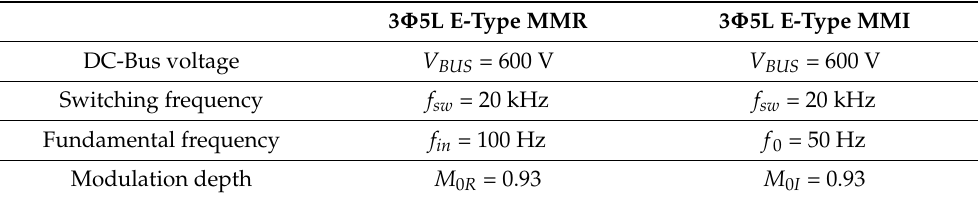
Figure 14. Total efficiency of the 3 Φ 5L E-Type MMC as a function of the power P 0 : analytical result Table 2. Operating parameters of the 3 Φ 5L E-Type MMR and MMI. (green line), simulation result (orange line). Table 2. Operating parameters of the 3 Φ 5L E-Type MMR and MMI.